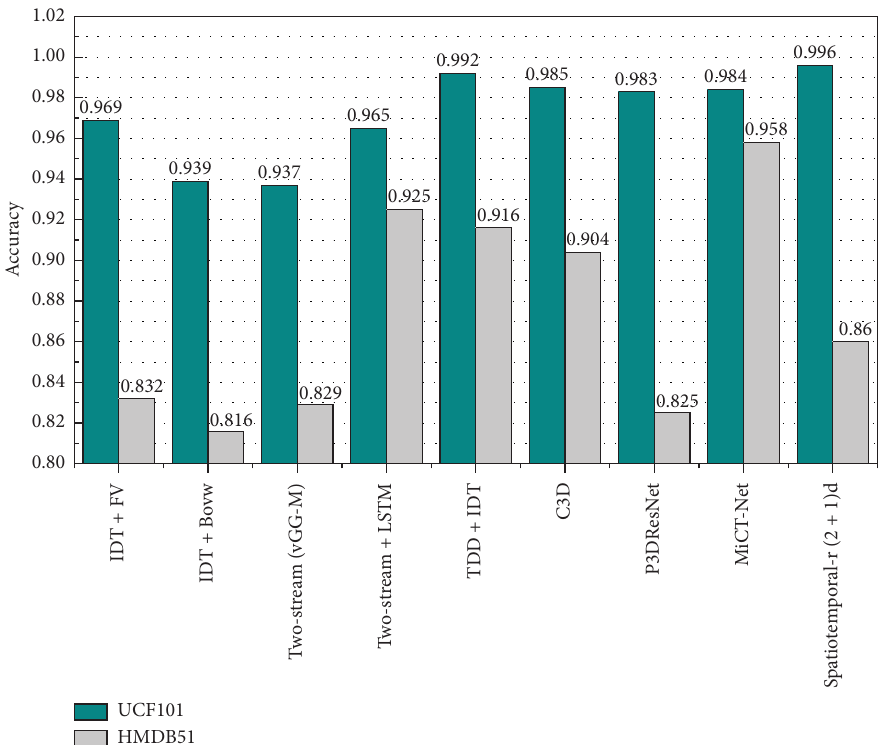
Figure 7: Comparison of video behavior recognition accuracy of different